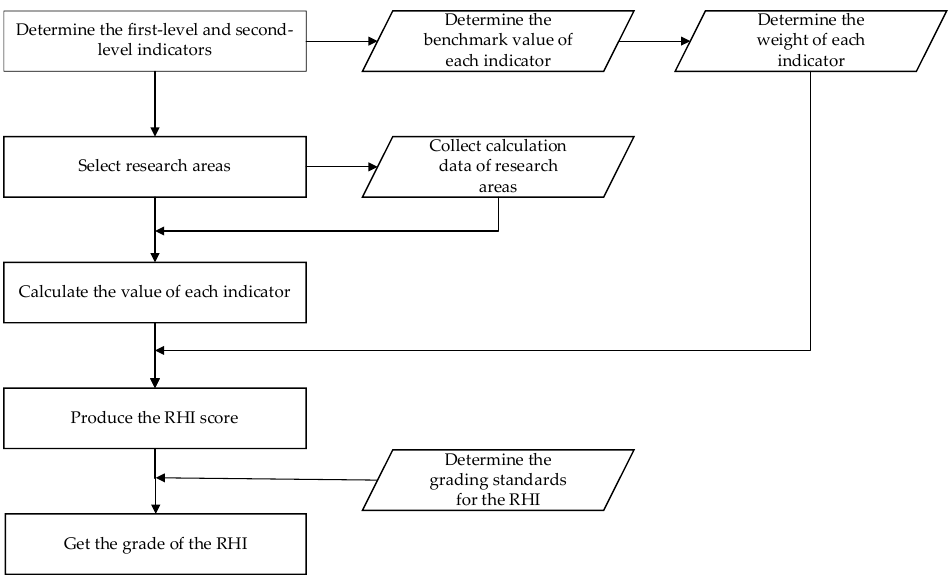
Figure 1. Flowchart of the RHI evaluation system.